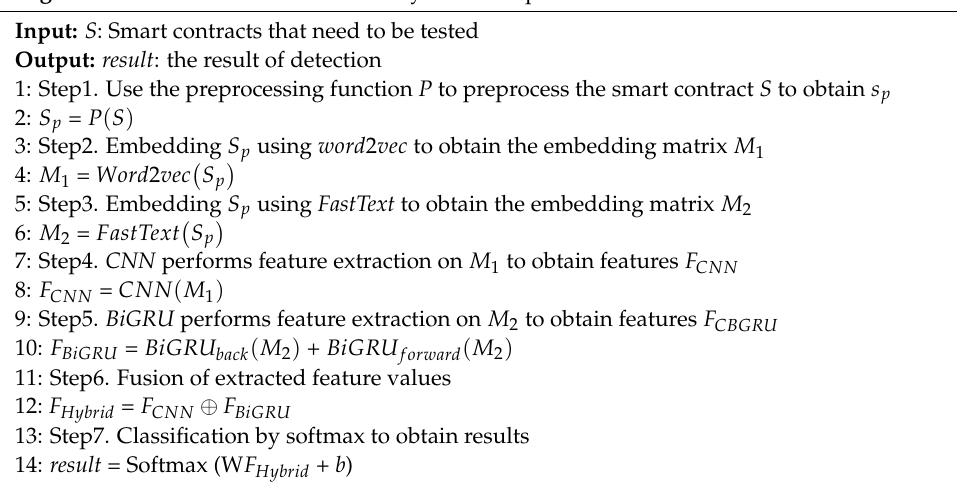
Algorithm 1 Smart contract vulnerability detection